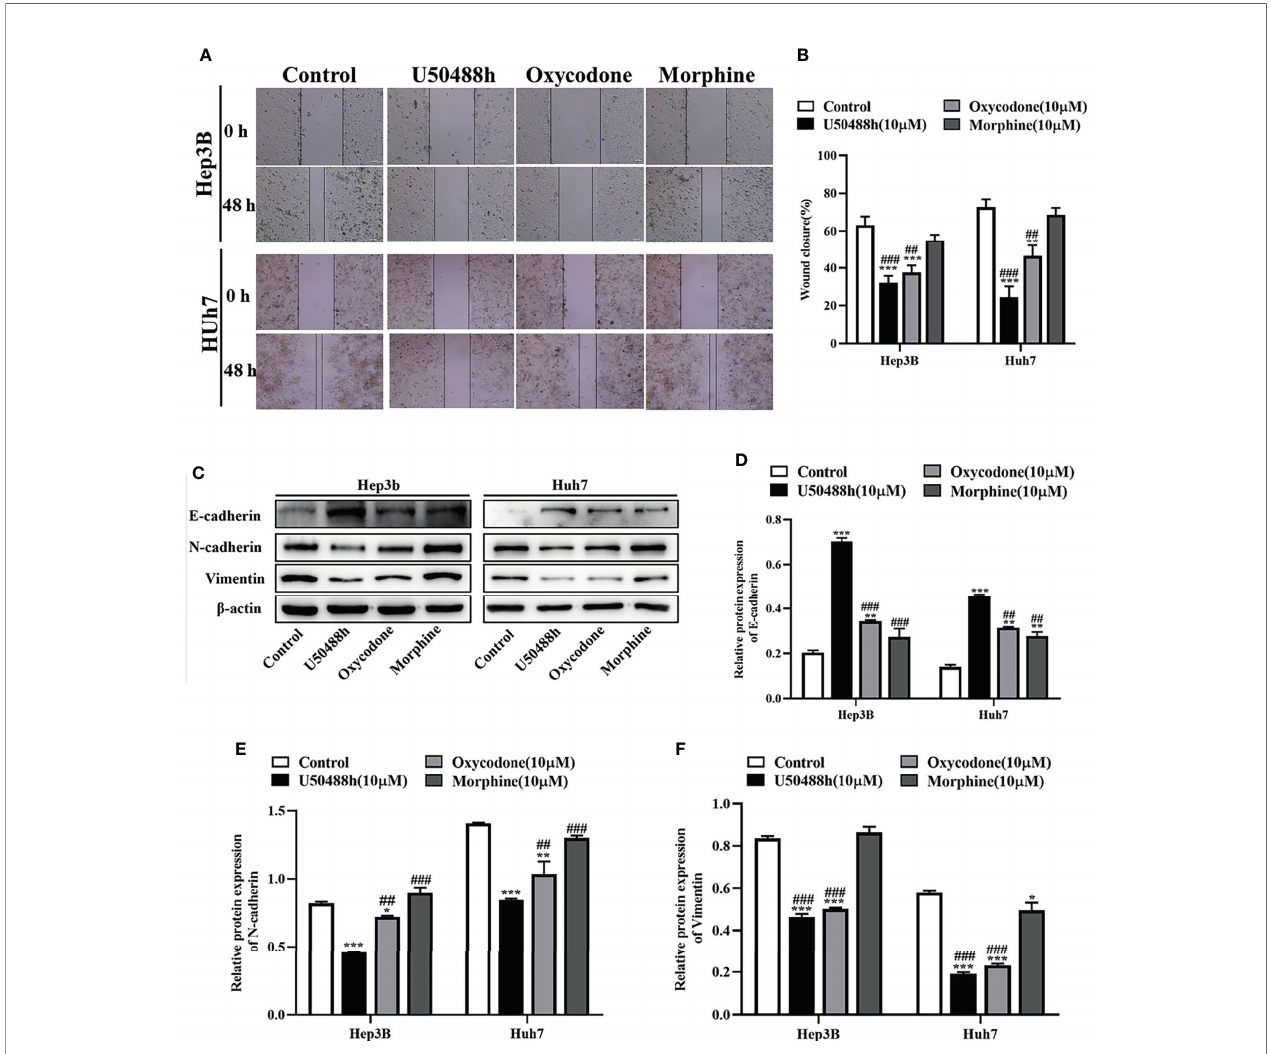
FIGURE 3 | KOR agonist U50488h and oxycodone decreases the migration of HCC cells. (A) Hep3B and Huh7 cells were treated with 10 m M U50488h, 10 m M oxycodone and 10 m M morphine for 48 h to detected the motility of cells, and wound healing assay was performed, scale bar=100 um. (B) Histogram represents the wound closure of cells. (C-F) Western blotting was used to detect the expression of E-cadherin, N-cadherin, Vimentin and b -actin in Hep3B and Huh7 cells treated with U50488h (10 m M), oxycodone (10 m M) and morphine (10 m M). b -actin was used as an internal control. Values are reported as the mean ± standard deviation (n = 3). *P < 0.05, **P < 0.01, ***P < 0.001 vs. control group; ## P < 0.01, ### P < 0.001vs. U50488h